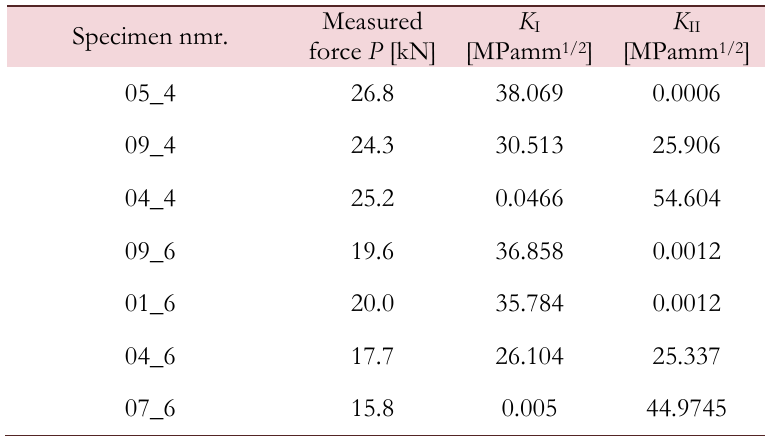
Table 6: Measured experimental load P and calculated fracture mechanical parameters K I and K II for each